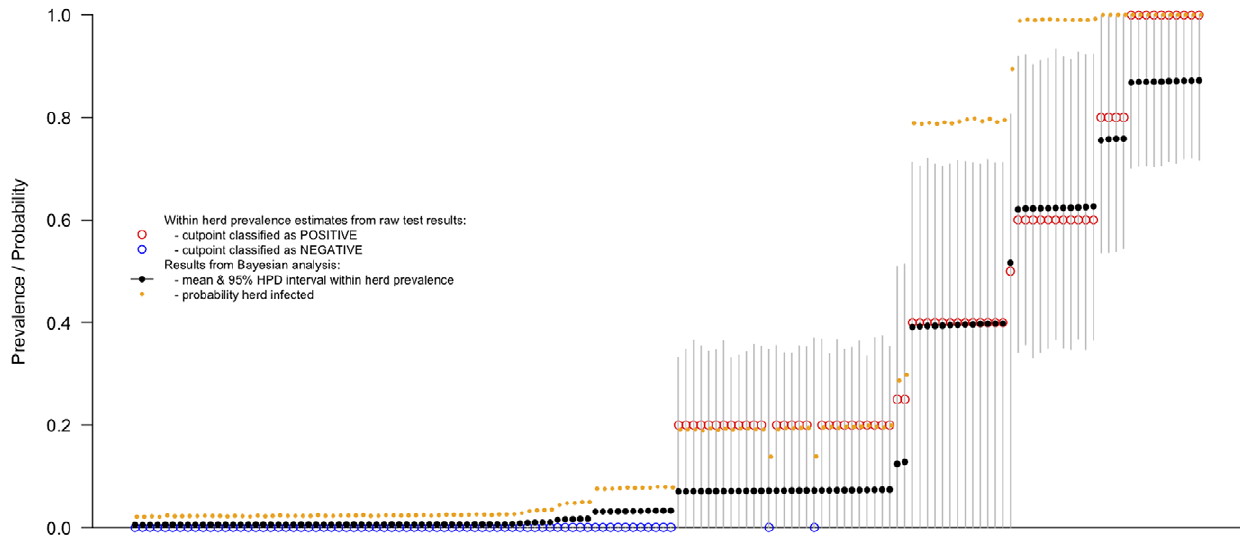
Figure 5. Caterpillar plots showing the estimated adjusted and unadjusted within-herd seroprevalence for each of the 142 herds based only on juvenile data, the 95% highest density intervals (HDI) for the adjusted seroprevalences and the probability that each herd is seropositive. Herds are ordered along the x axis based on the estimated within-herd seroprevalence.